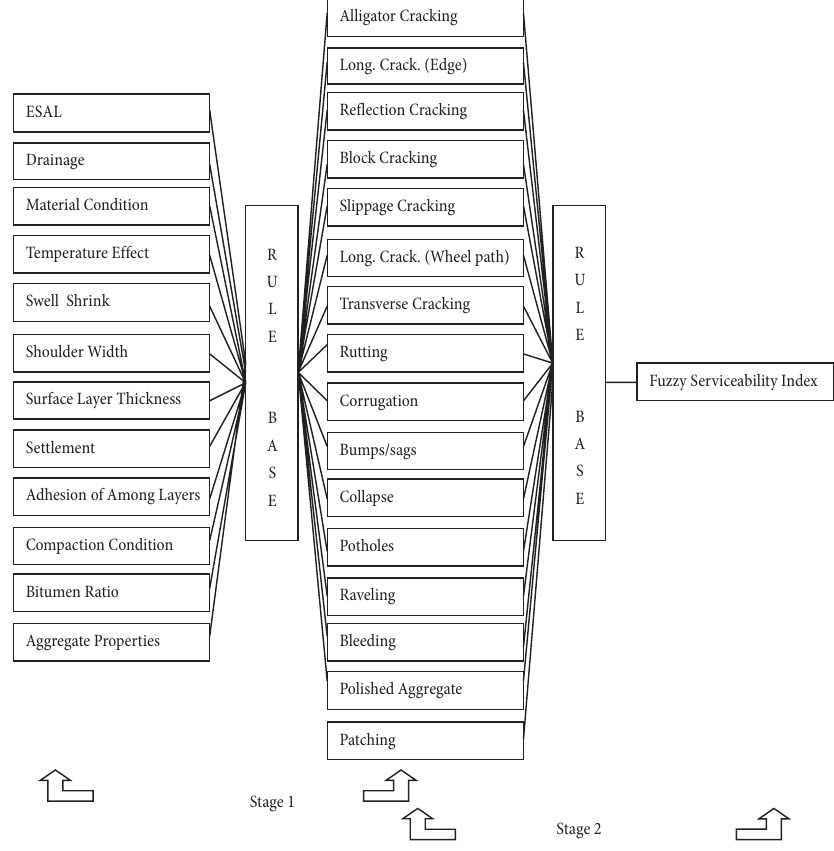
Fig. 4. General structure of the